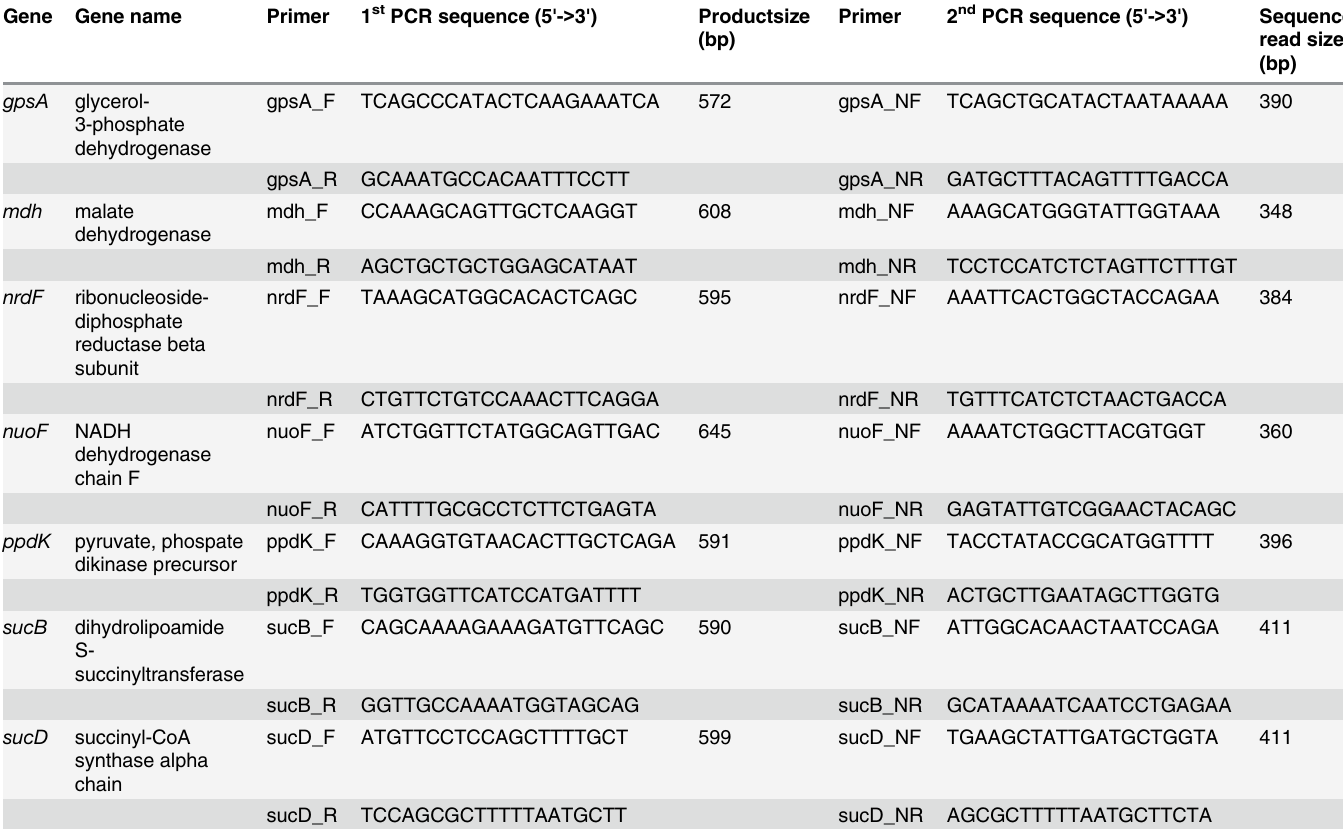
Table 1. List of 7 housekeeping gene and primer sequences used in this study.